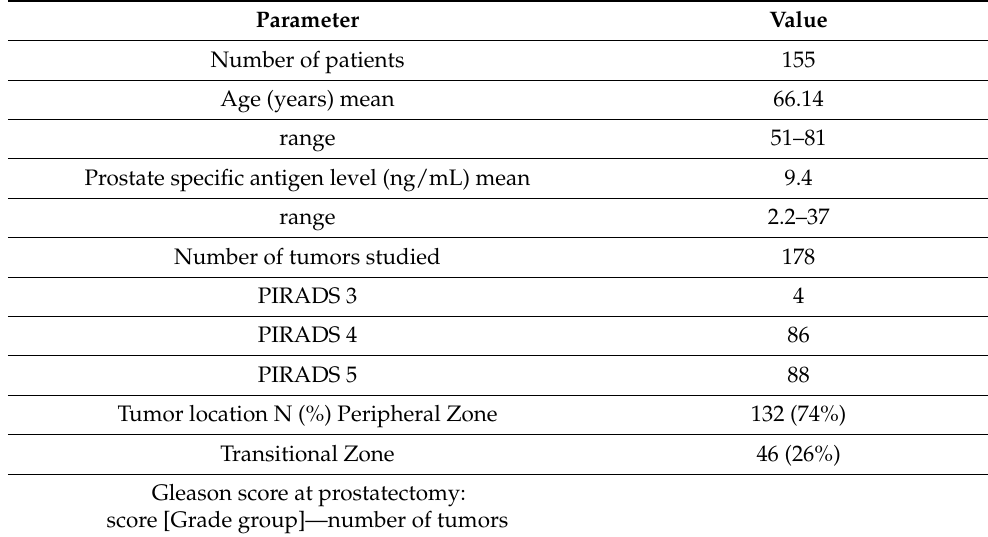
Table 1. General characteristics of study